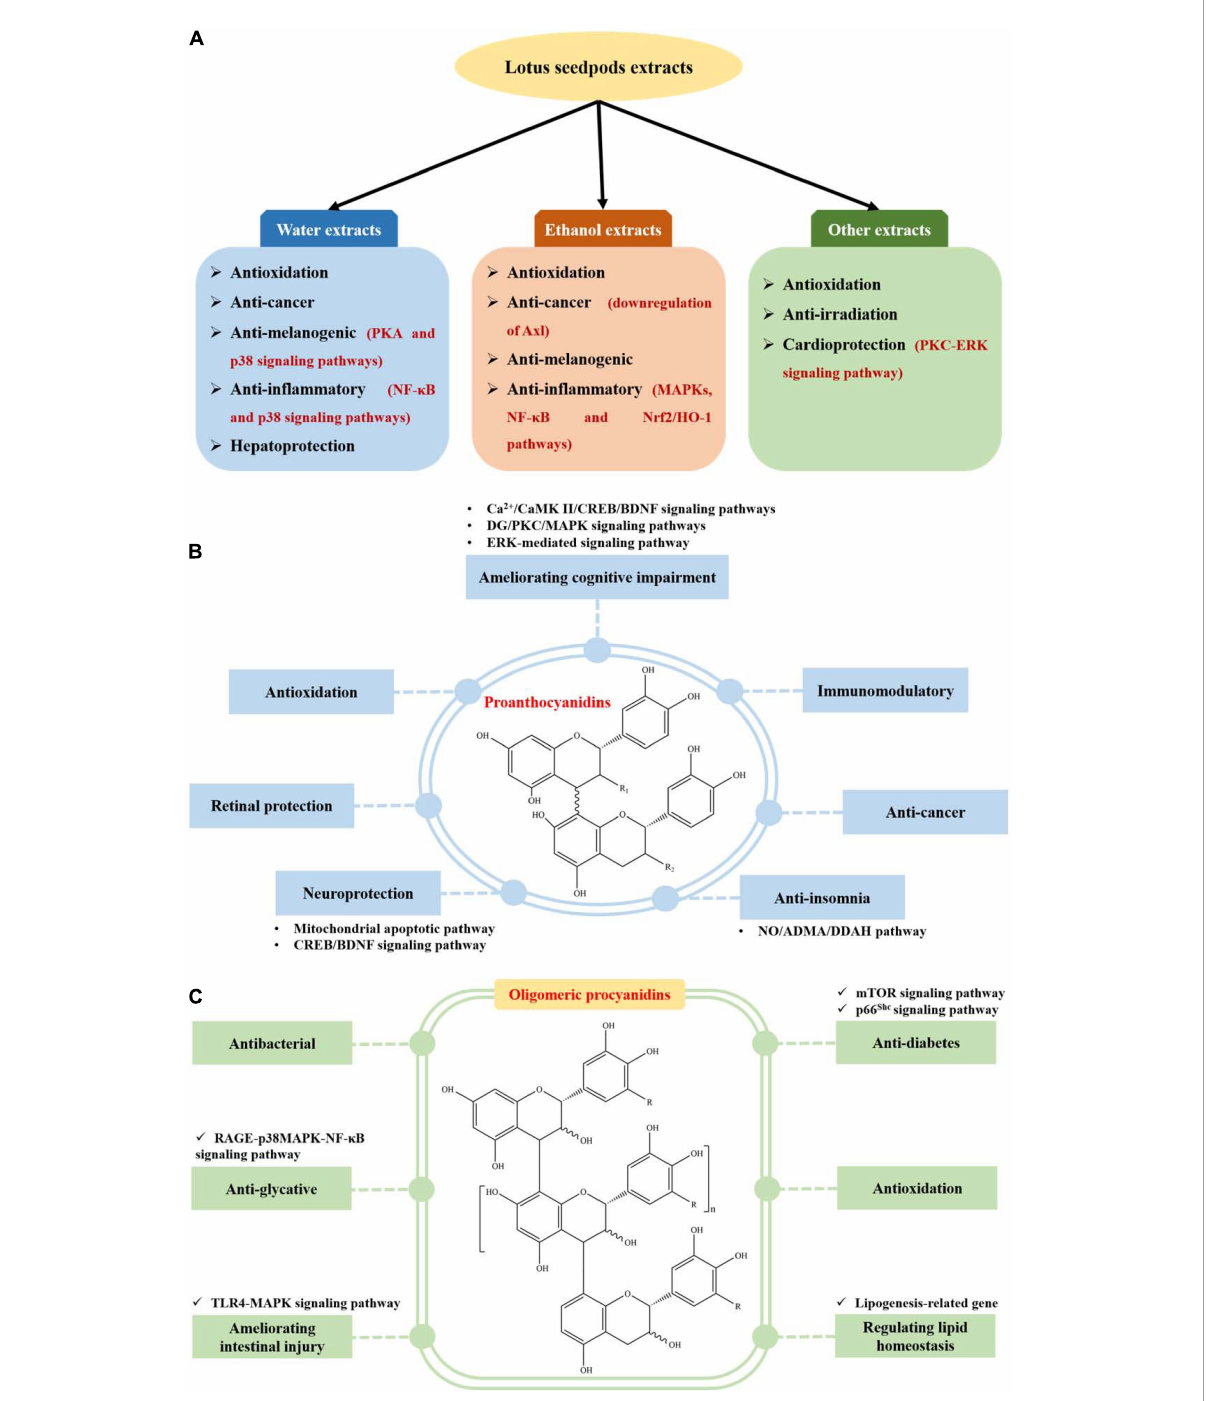
FIGURE3 Biological activities of extracts (A) , proanthocyanidins (B) , and oligomeric procyanidin (C) from lotus seedpods.